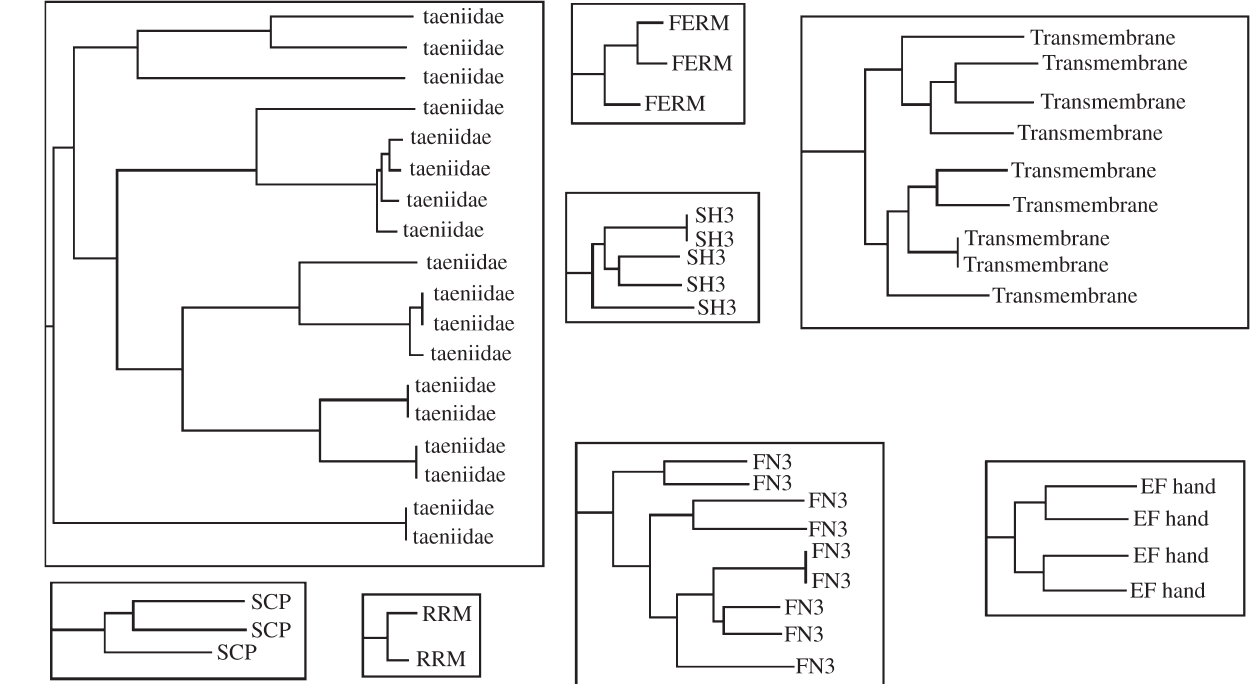
Figure 6 - Hierarquical clustering by